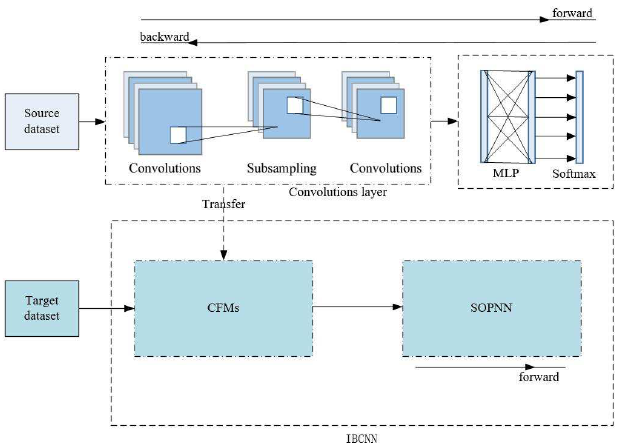
Figure 5. The network structure of